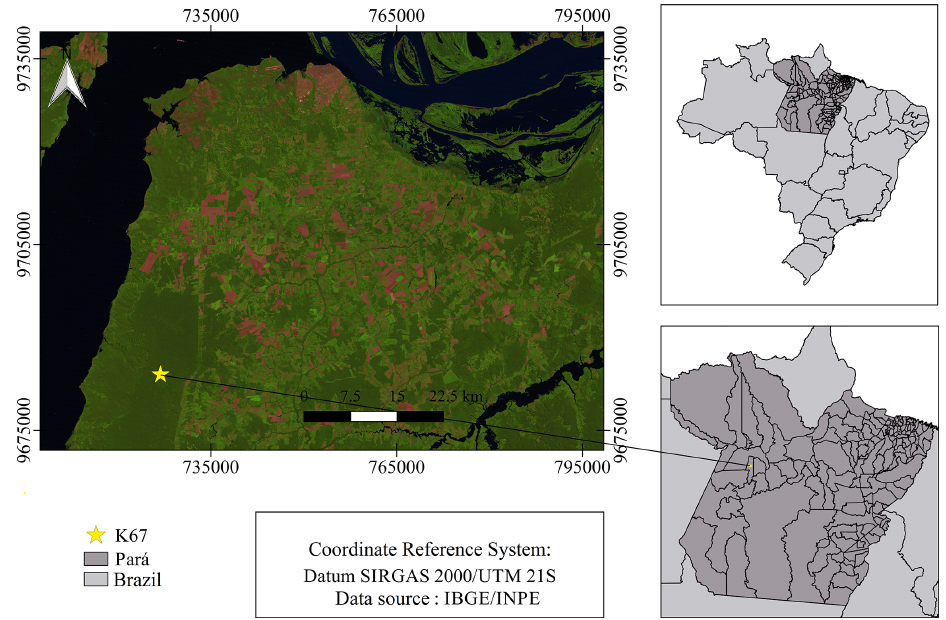
Figure 1. Location of the flux measurement site (yellow star) in the state of Pará, Brazil, obtained from Landsat imagery courtesy of the Brazilian Institute for Space Research (INPE Landsat). The map of Brazil and the state of Pará (right side of the figure) were obtained from the IBGE (Brazilian Institute of Geography and Statistics)